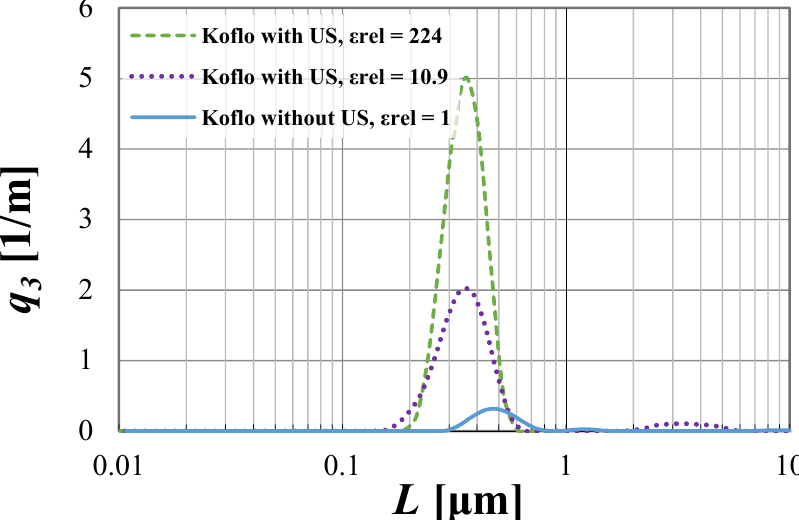
Figure 4. Particle density distributions of crystals obtained for different values of ε rel by the use of Koflo STM.